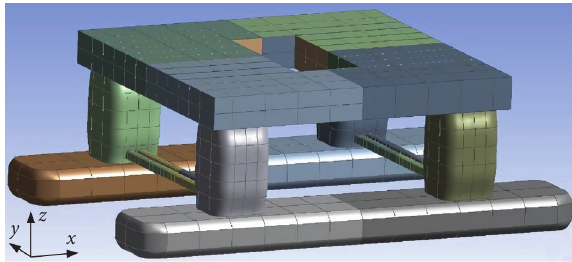
Figure 1: The basic model of a semisubmersible platform. Table 1: The dimensions of the semisubmersible platform model.